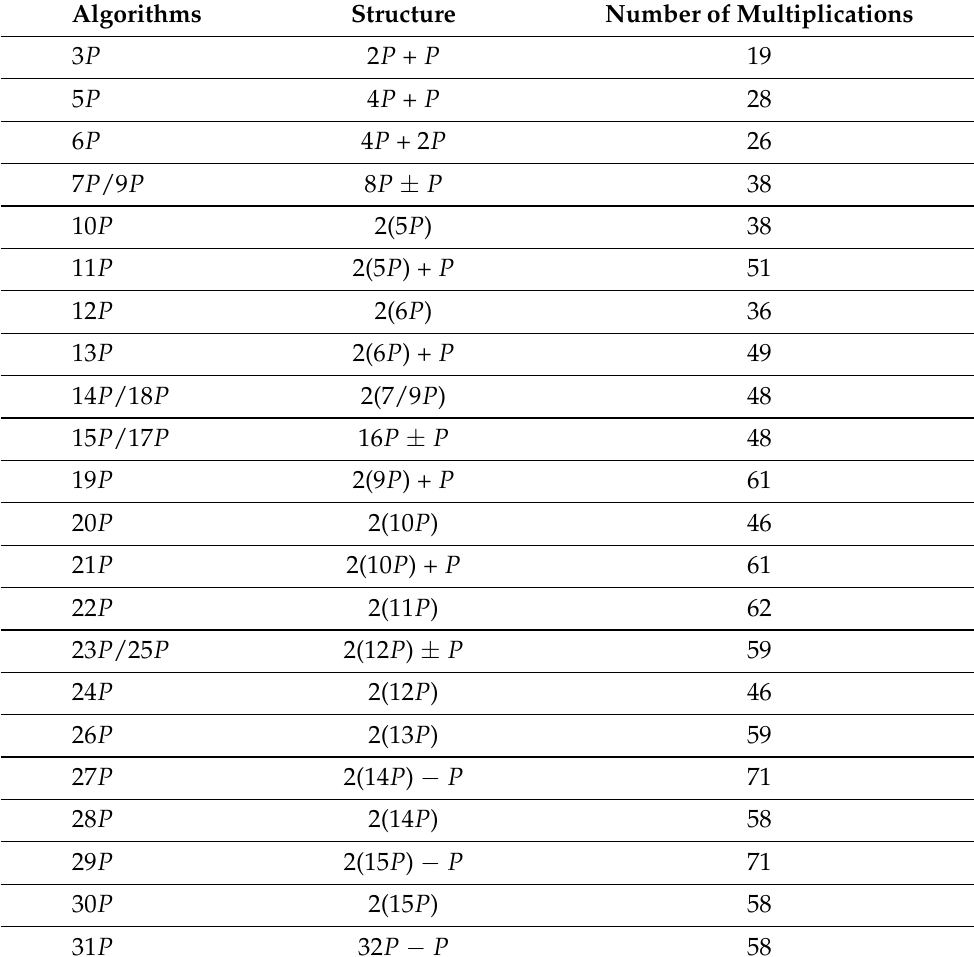
Table 2. Structure and Cost for All Intermediate